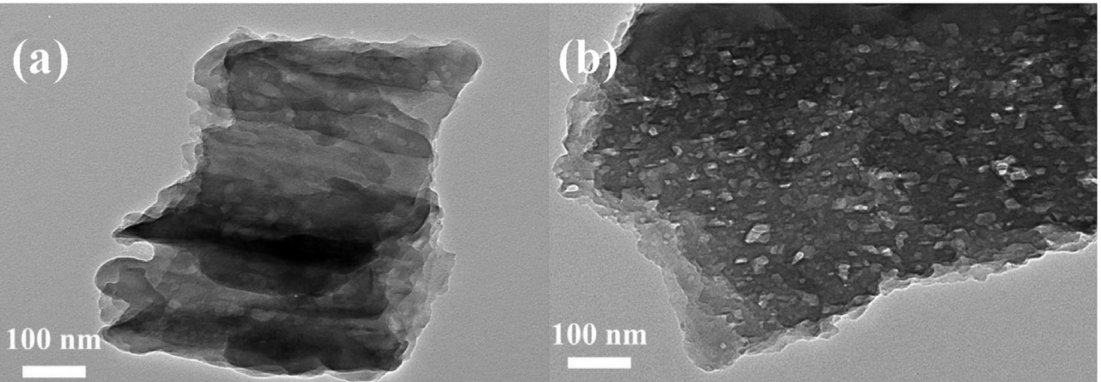
Figure 13. The TEM image of ( a ) pure GCN, and ( b ) porous Na, P-GCN. Reproduced with permission from Ref.